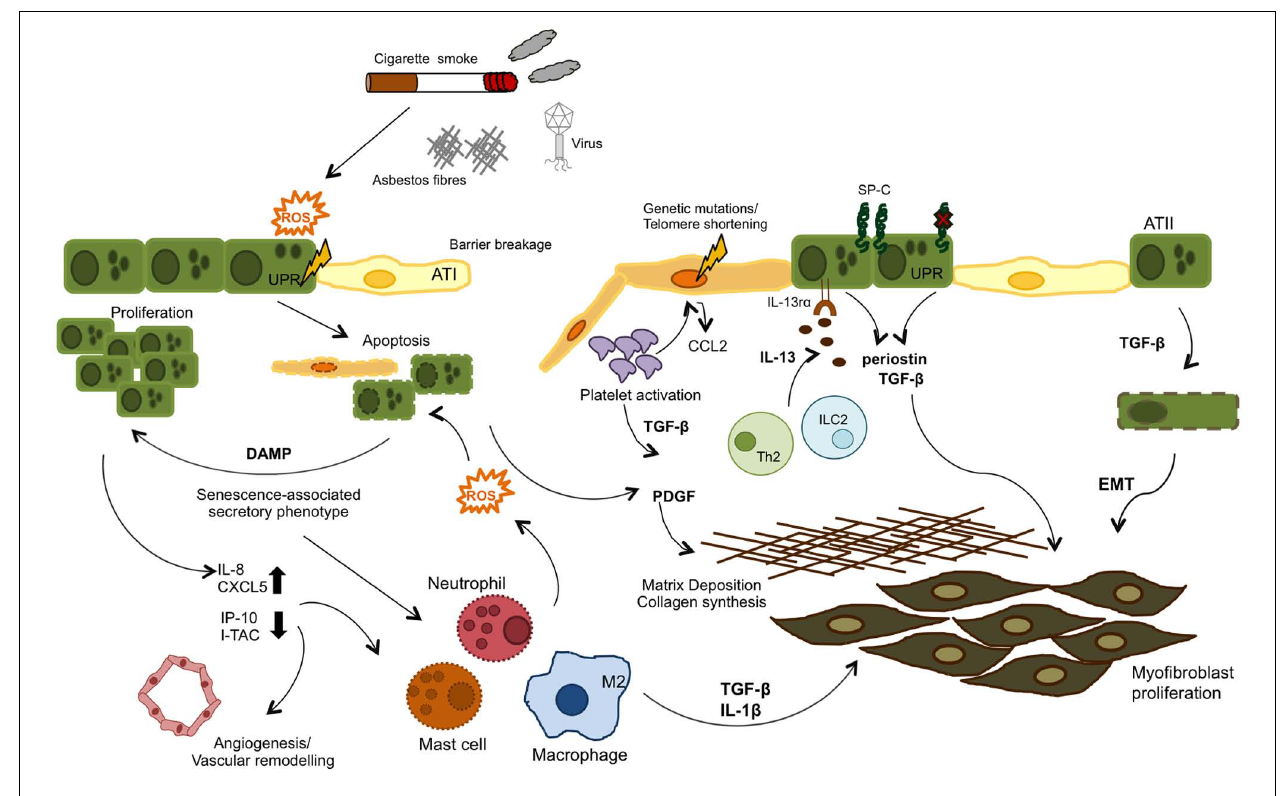
chemokines, and danger-associated molecular patterns (DAMPs) which in turn recruit leukocytes to the site of injury and also activate the coagulation cascade, in an attempt to repair the damage. In IPF, these pathways become dysregulated and inflammatory cell types contribute to the unresolved damage/repair by secretion of TGF - β , IL -13, and ROS, which provide repeated injury to epithelial cells and induce their hyper-proliferation. TGF - β is also produced by activated platelets and contributes to the fibrotic state by inducing EMT, fibroblast proliferation and collagen synthesis, and ECM